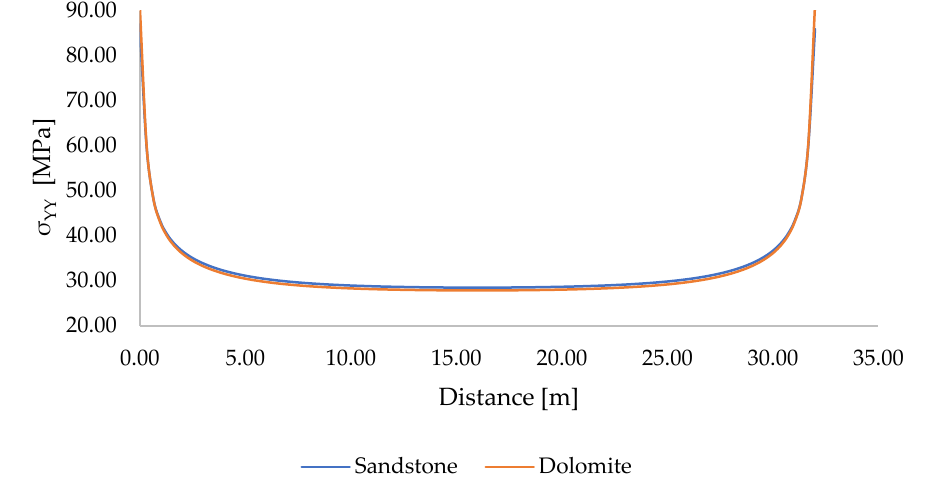
Figure 12. Distribution of σ YY stresses acting on the protective pillars in the cross-section through the ramps.